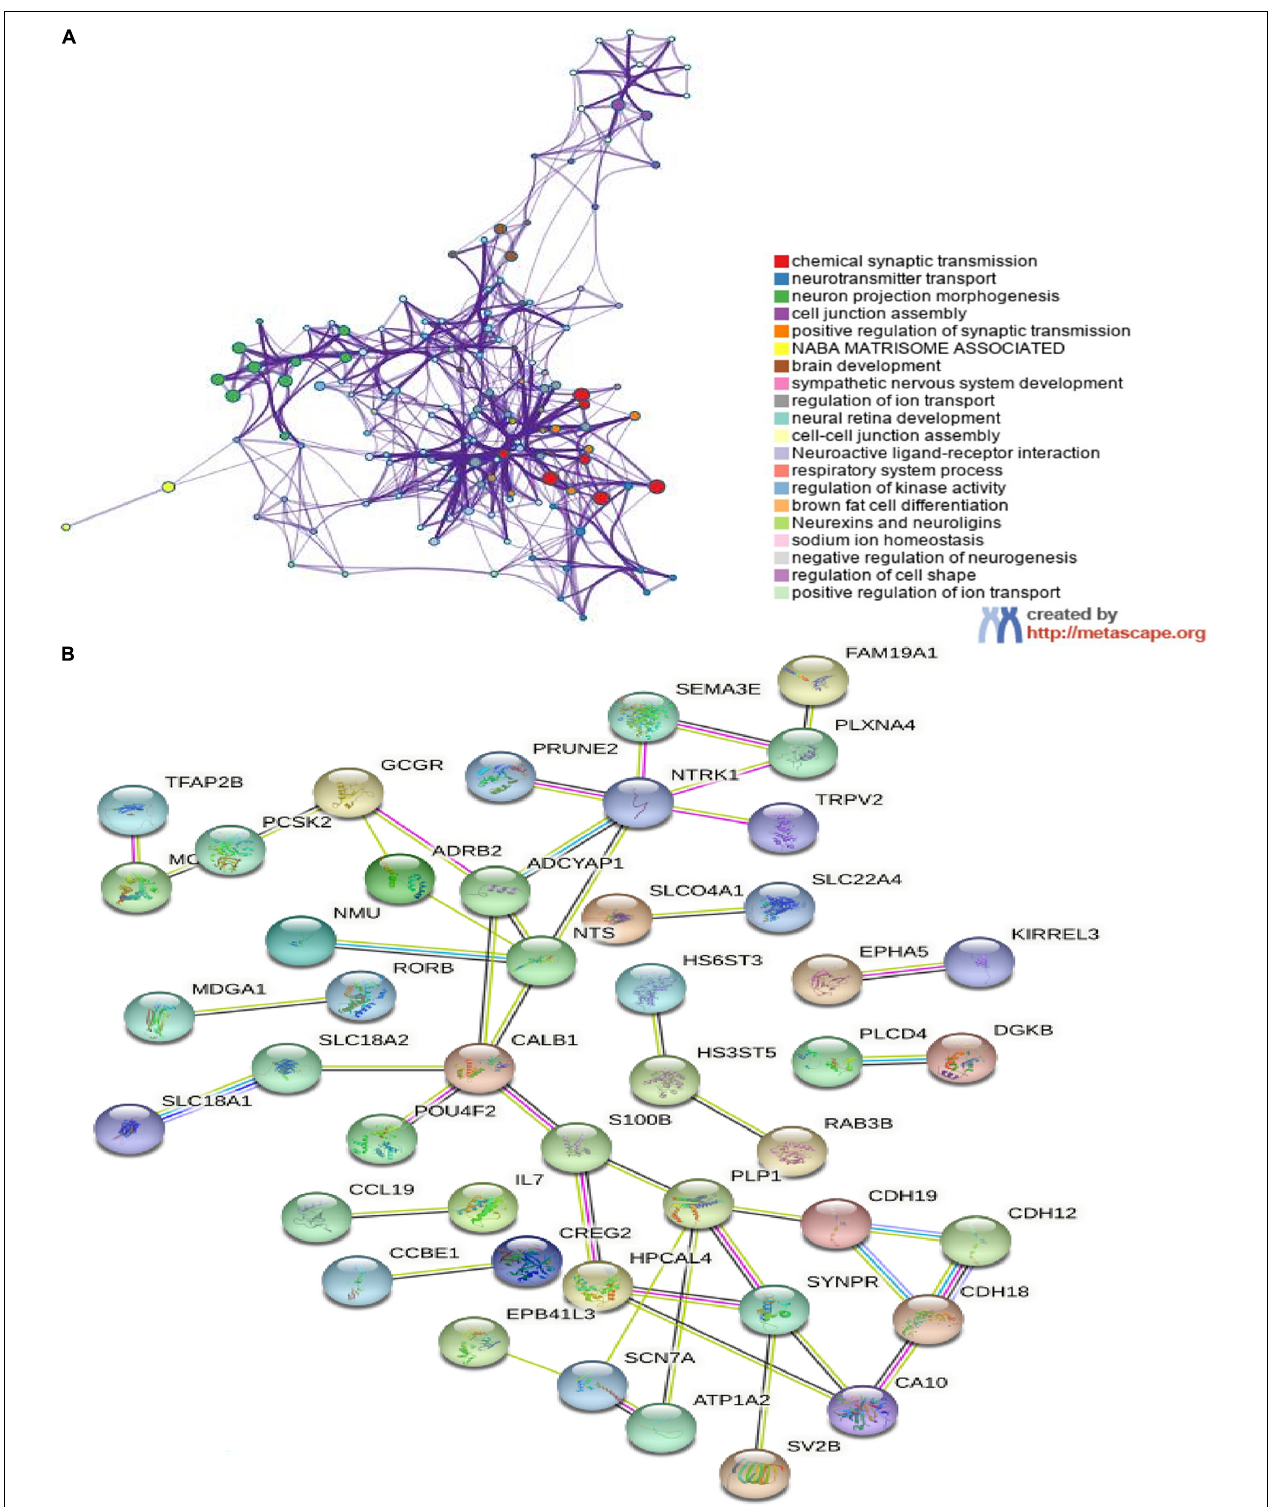
FIGURE 3 | The enrichment analyses in metascape and protein–protein interaction (PPI) analyses in STRING. (A) Detailed information relating to changes in the biological function of DEGs in datasets through the enrichment analyses. Network of enriched terms colored by cluster identity, where nodes that share the same cluster identity are typically close to each other; (B) PPI network of DEGs. An interaction score > 0.9 was set as significant differences and isolated nodes were removed.